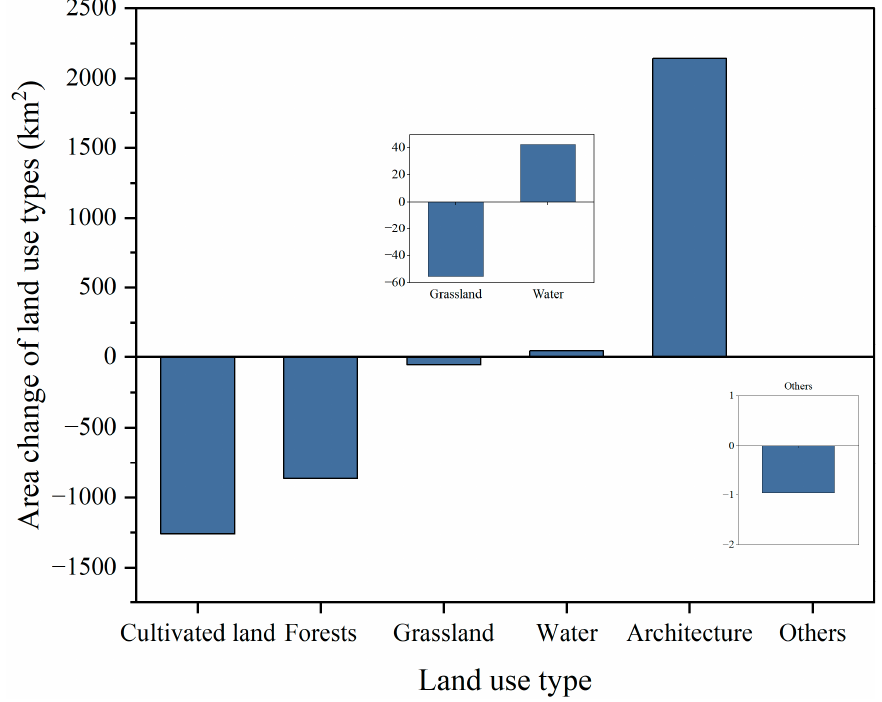
Figure 9. Area changes in land use types in the natural development scenario from 2020 to 2035.